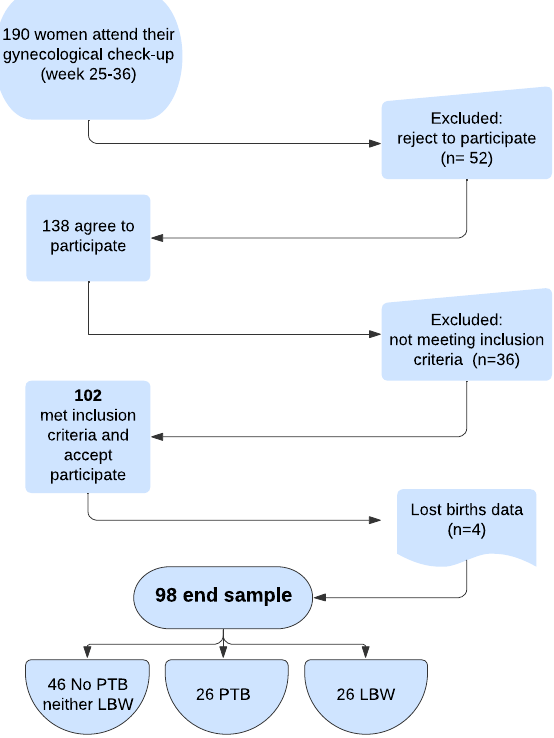
Figure 1. Flow chart about end sample selection.